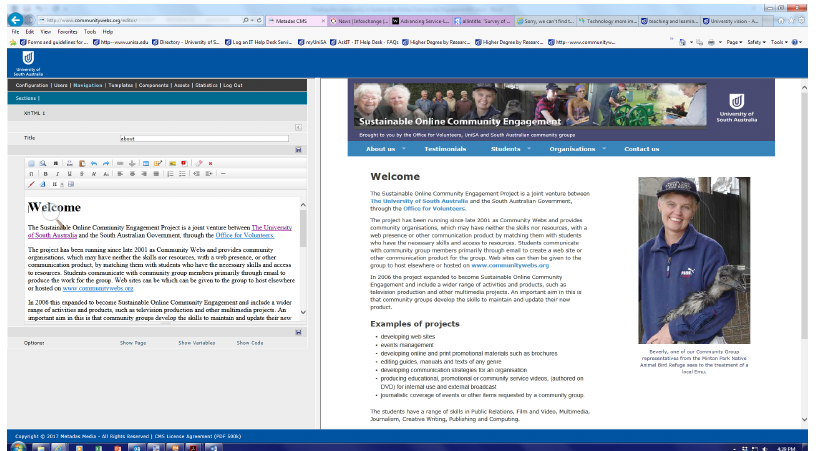
Figure 2: Editing interface of the custom-built CMS first adopted by